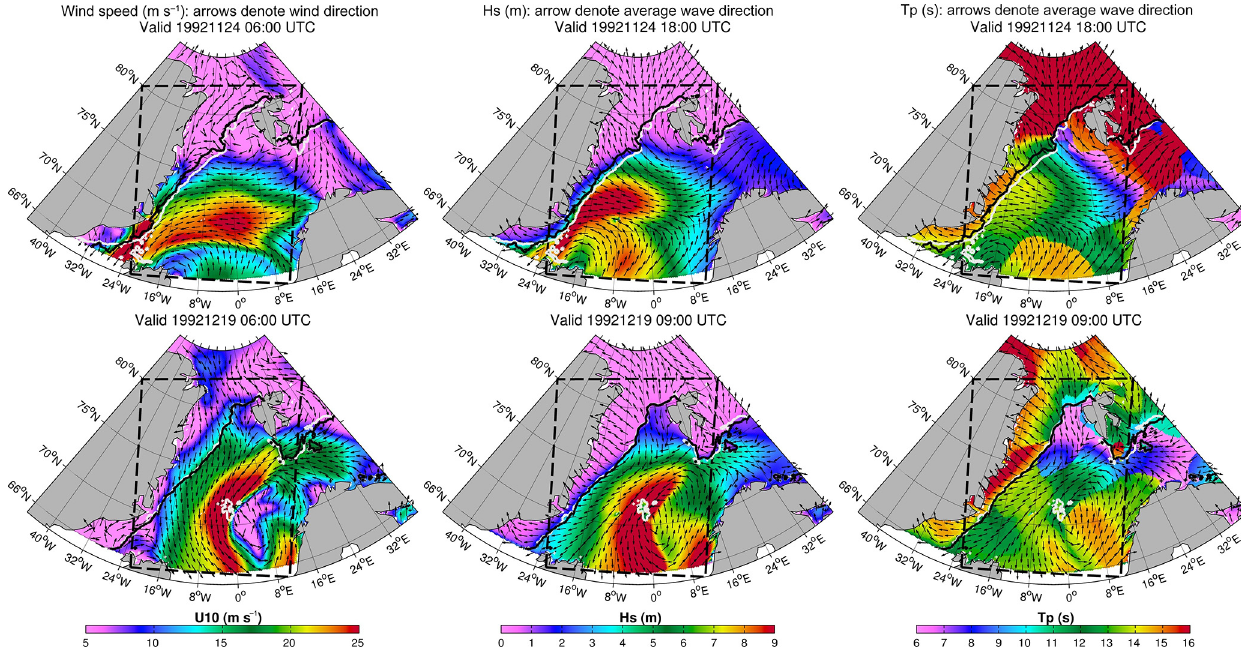
Figure 11. Wind speeds, significant wave heights, and peak periods for events in November and December 1992. The arrows denote the wind direction or average wave direction. The contour lines represent the 15% ice concentration before (white) and after (black) the